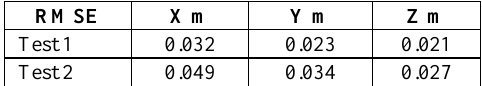
Table 2: Check point RMSE from the manual matching test